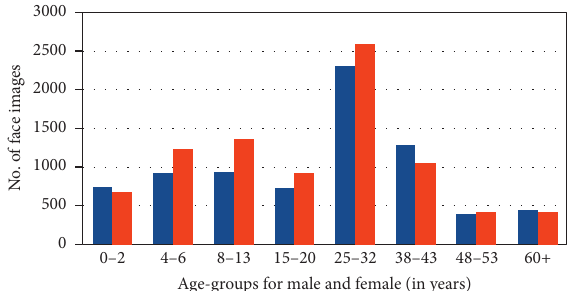
Figure 4: The number of image samples for age group and gender in OIU-Adience